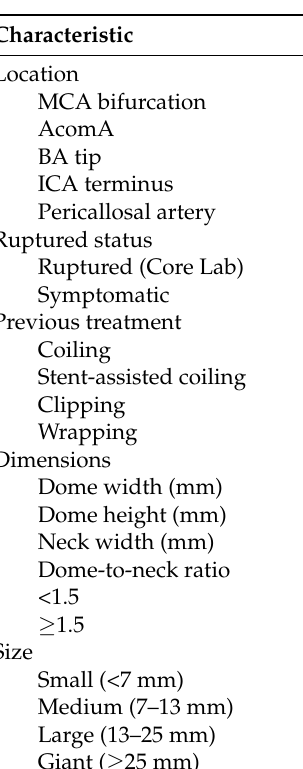
Table 2. Aneurysm characteristics (ITT